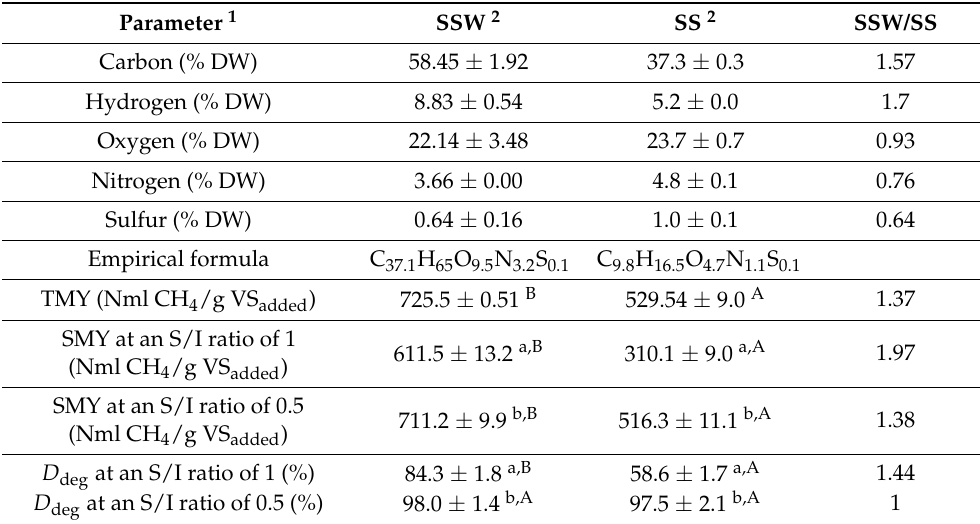
Table 4. Ultimate analysis, empirical formula, TMY, SMY, and degree of anaerobic digestion ( D deg ) from SSW and